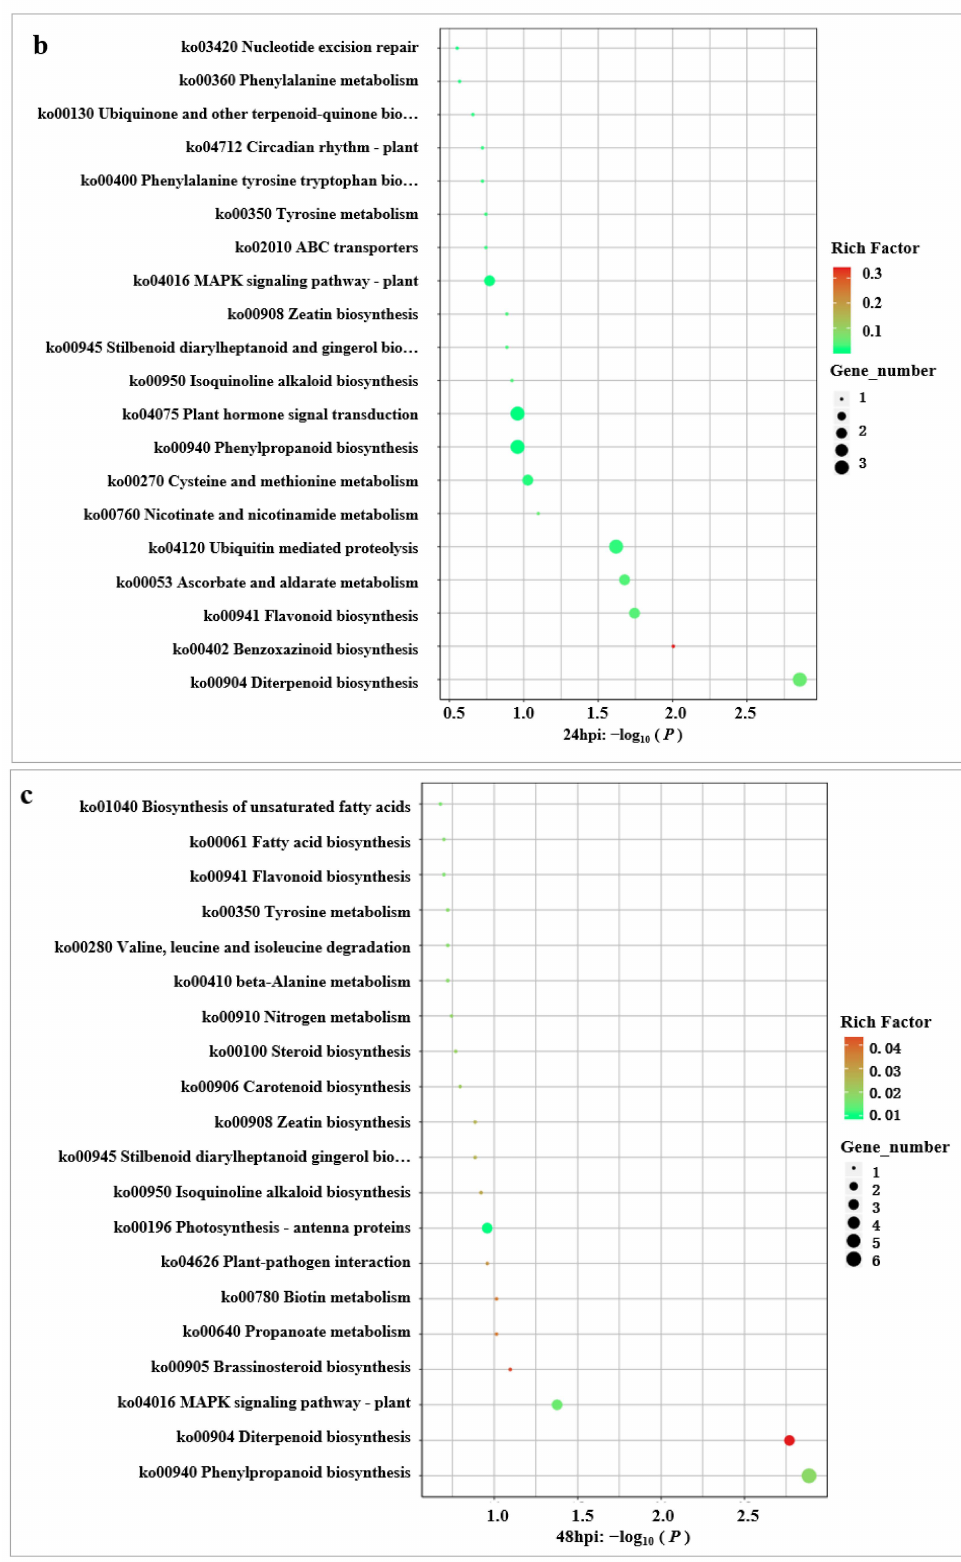
Figure 4. WT-vs-MT: KEGG enrichment significance analysis bubble chart ( p < 0.01). ( a ) 12 hpi KEGG enrichment significance analysis bubble chart. ( b ) 24 hpi KEGG enrichment significance analysis bubble chart. ( c ) 48 hpi KEGG enrichment significance analysis bubble